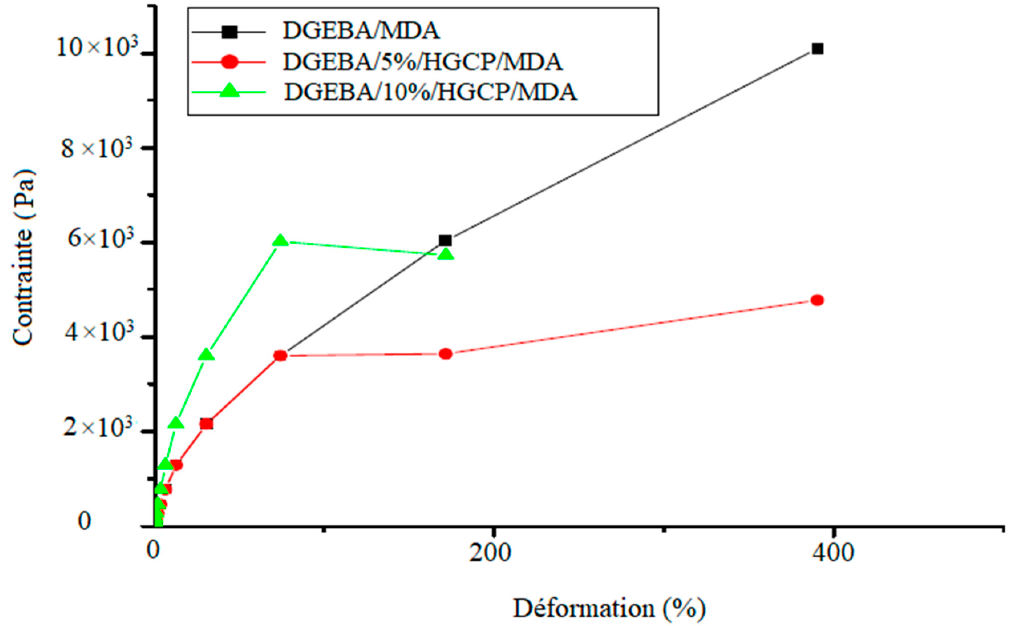
Figure 7. Stress-strain curves for DGEBA samples with different amounts of HGCP (0%, 5% and 10%).